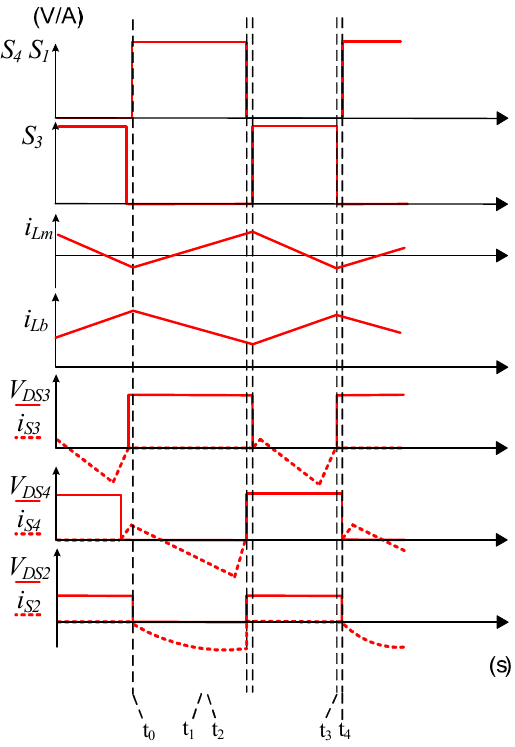
Figure 7. Waveform diagram of operation of main components in Stage 3.